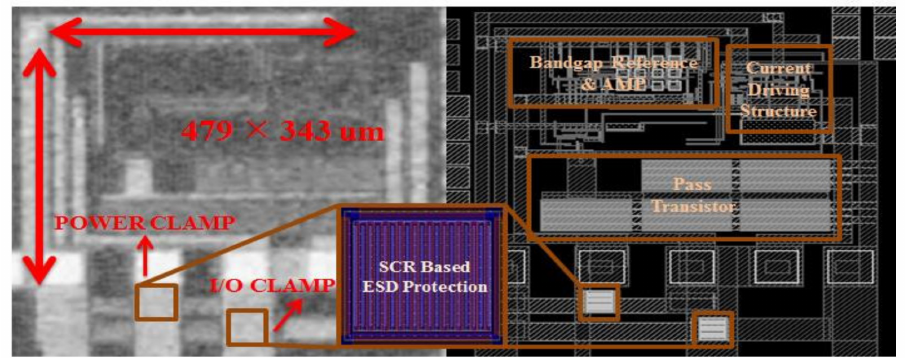
Figure 9. Chip layout of the proposed LDO